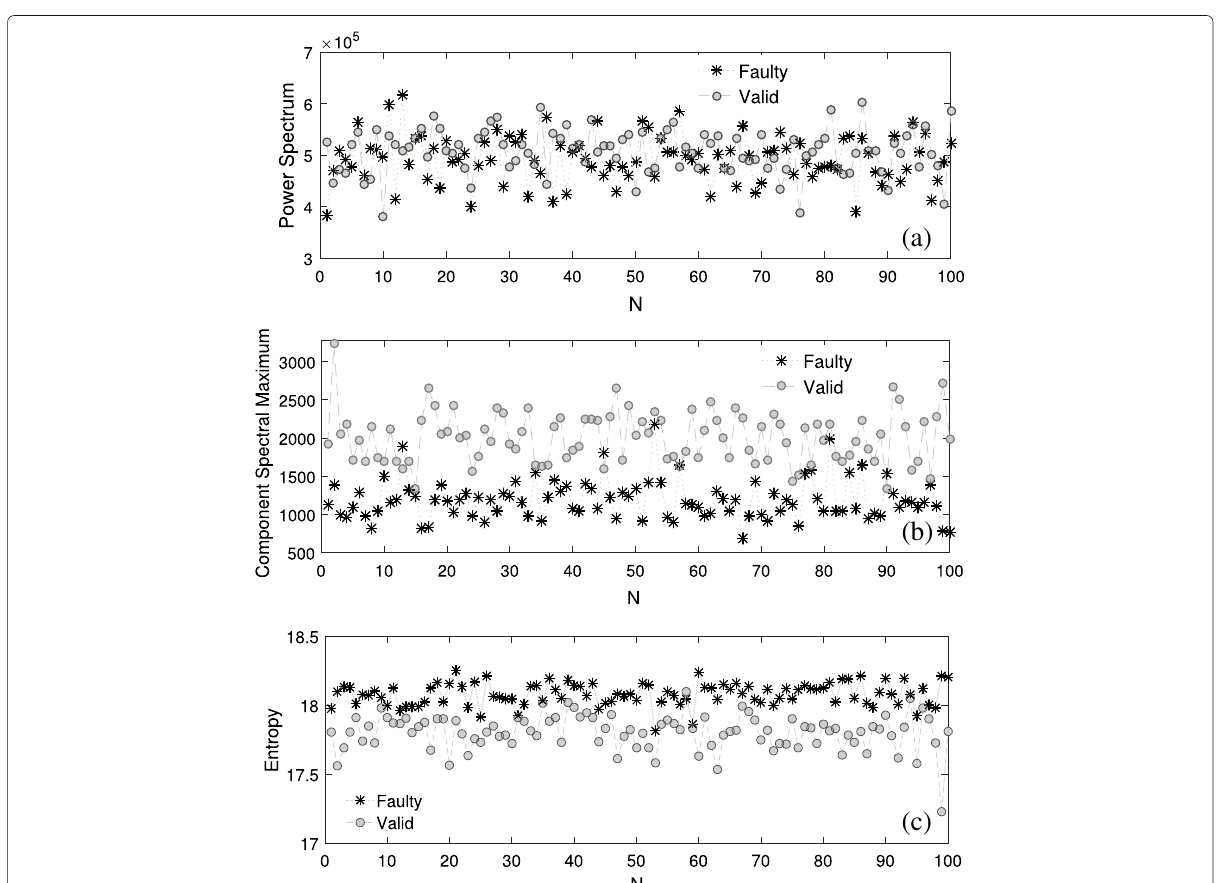
Fig. 8 Simulated results for a signal energy, b spectrum maximum value inside components’ bandwidth, and c global entropy value for simulated